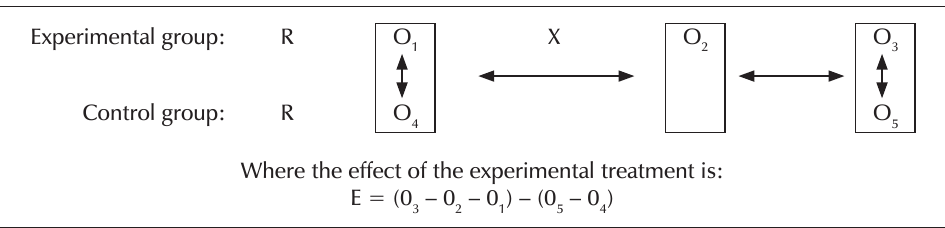
Figure 2 The true experimental